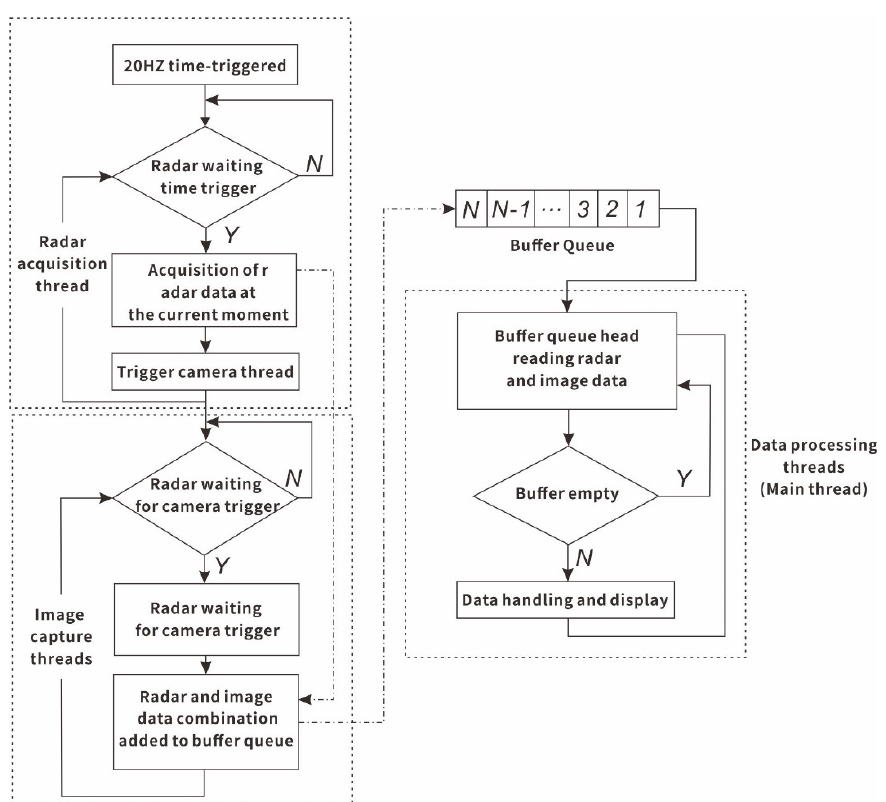
Figure 4. Flowchart of time registration.